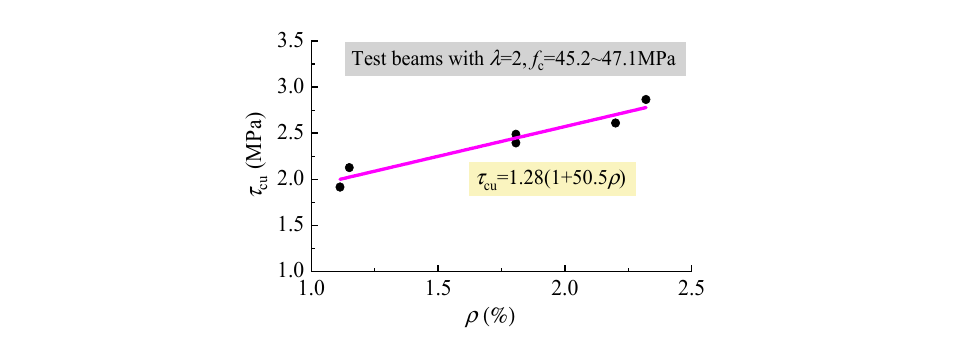
Figure 11. Variations of τ cu with f fc and f ft.